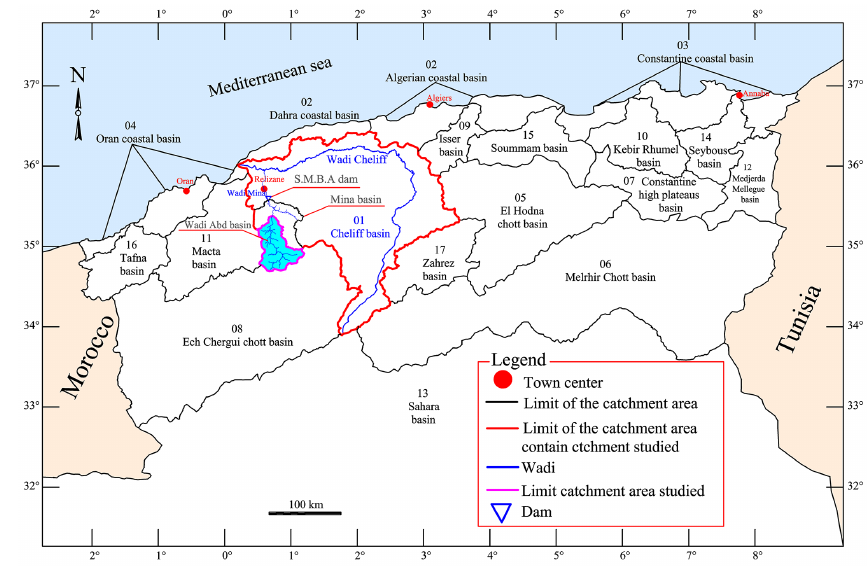
Figure 1. Location of the Wadi Abd sub-basin within the Mina and Cheliff basins, and the other main basins of Algeria.